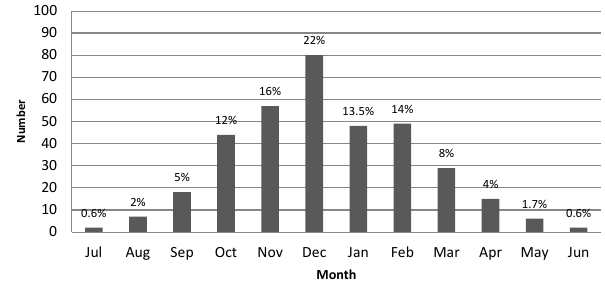
Figure 5. Monthly distribution in percentage of hail frequency in the